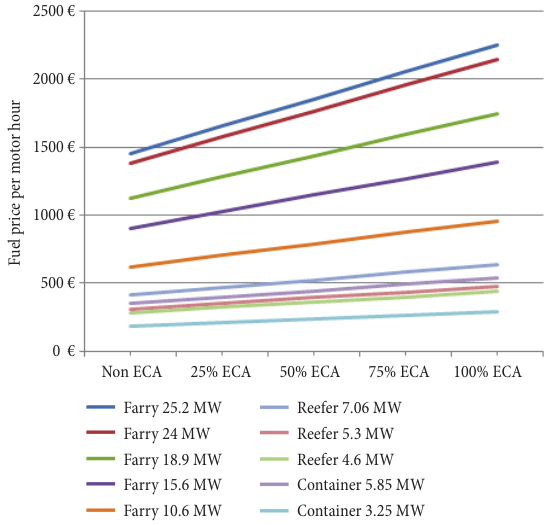
Fig. 2. Operational cost of each vessel